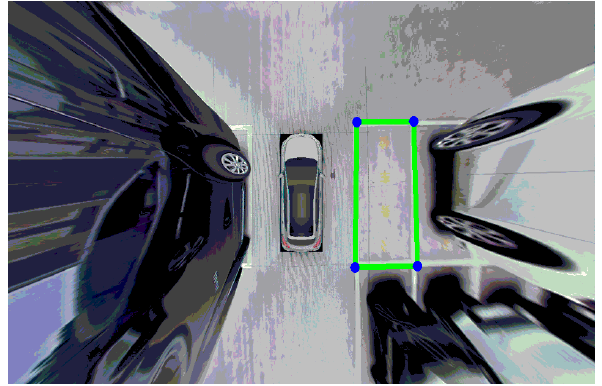
Figure 25. Hough transform.